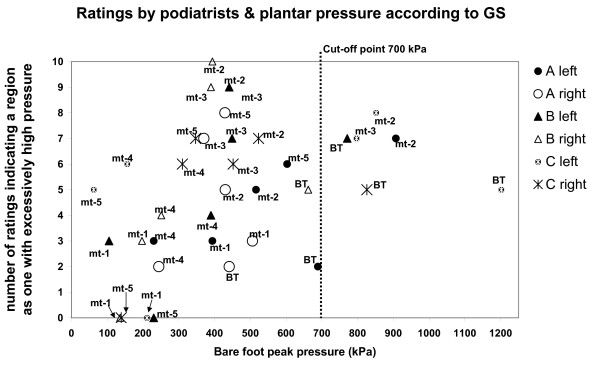
Ratings by podiatrists. The distribution of ratings of podiatrists who indicated a region as one with excessively high pressure, against the plantar pressure measured with the pressure platform (Gold Standard).